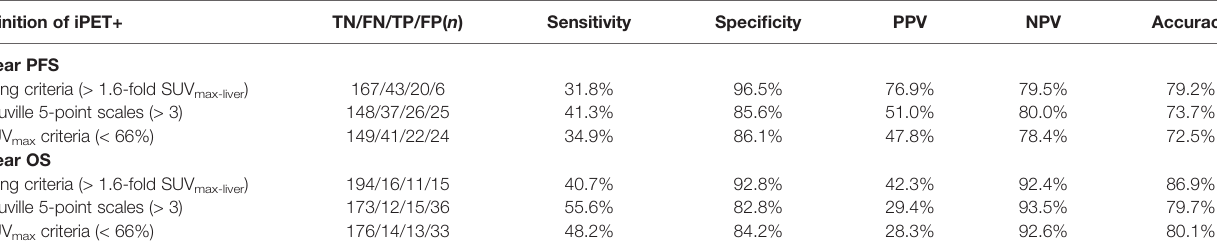
TABLE 3 | Accuracy of interim 18 F-FDG PET/CT scan after four cycles of therapy (PET-4) interpreted using different image interpretation methods (n = 236). De fi nition of iPET+